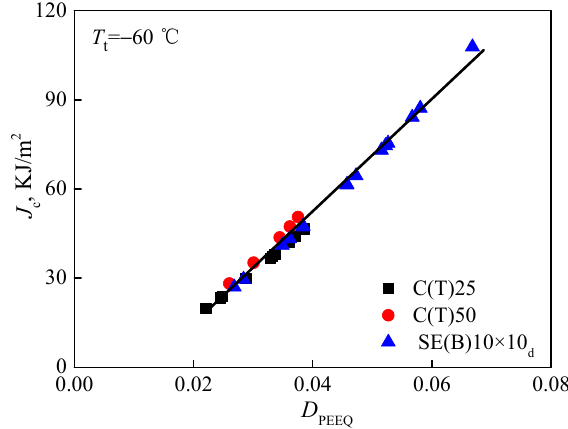
Jc and constraint parameter D PEEQ .